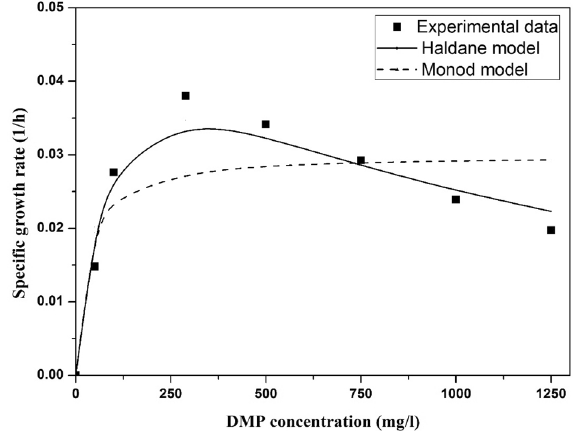
Figure 6. Experimental and model predicted specific growth rates of the Micrococcus sp. KS2 at various DMP